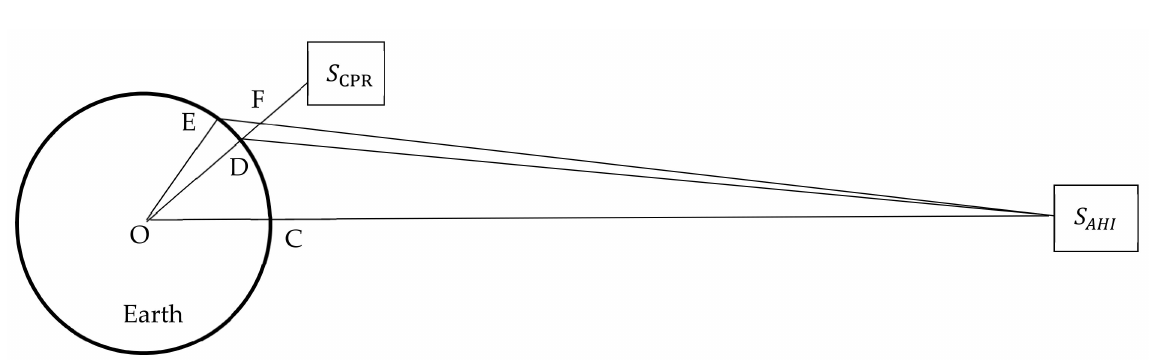
Figure A1. Schematic representation of viewing geometries from space-to-earth view for two satellites of HMW8/AHI (satellite S AHI ) and CloudSat (satellite S CPR ) for the deep convective cloud. C is the subsatellite point of HMW8/AHI on the equator and D, the footprint of deep convective cloud, could be at any